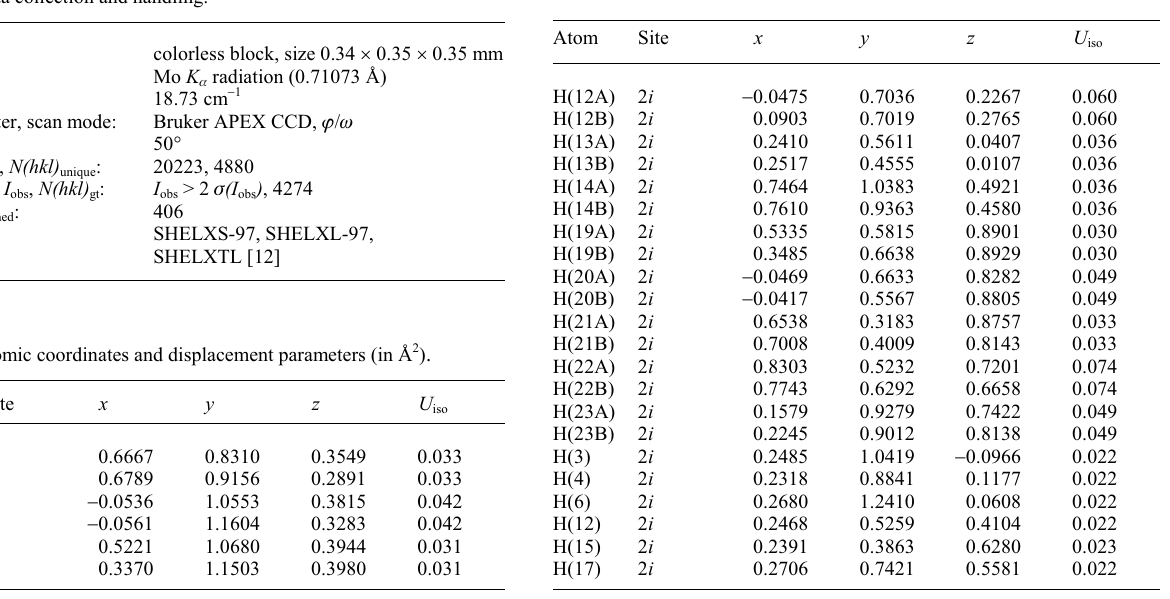
Table 1. Data collection and